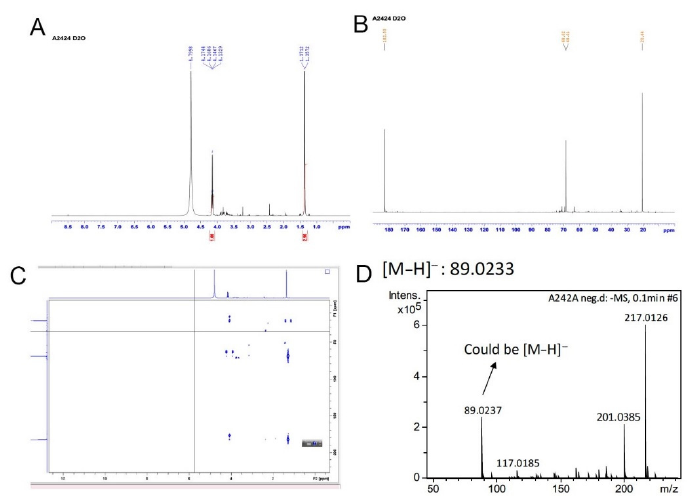
Figure 3. Chemical analyses for A2-4-2-4. A2-4-2-4 was analyzed using NMR and ESIMS. ( A ) The 1 H-NMR graph indicates a methyl group ( δ H 1.3, d, J = 7.0 Hz) and a methane group ( δ H 4.16, q, J = 7.0 Hz) in A2-4-2-4. ( B ) The 13 C-NMR indicates a carboxyl group ( δ C 182.5), a hydroxyl group ( δ H 68.6), and a methyl group ( δ H 20.4) in the major compound in A2-4-2-4. ( C ) The 2-dimensional